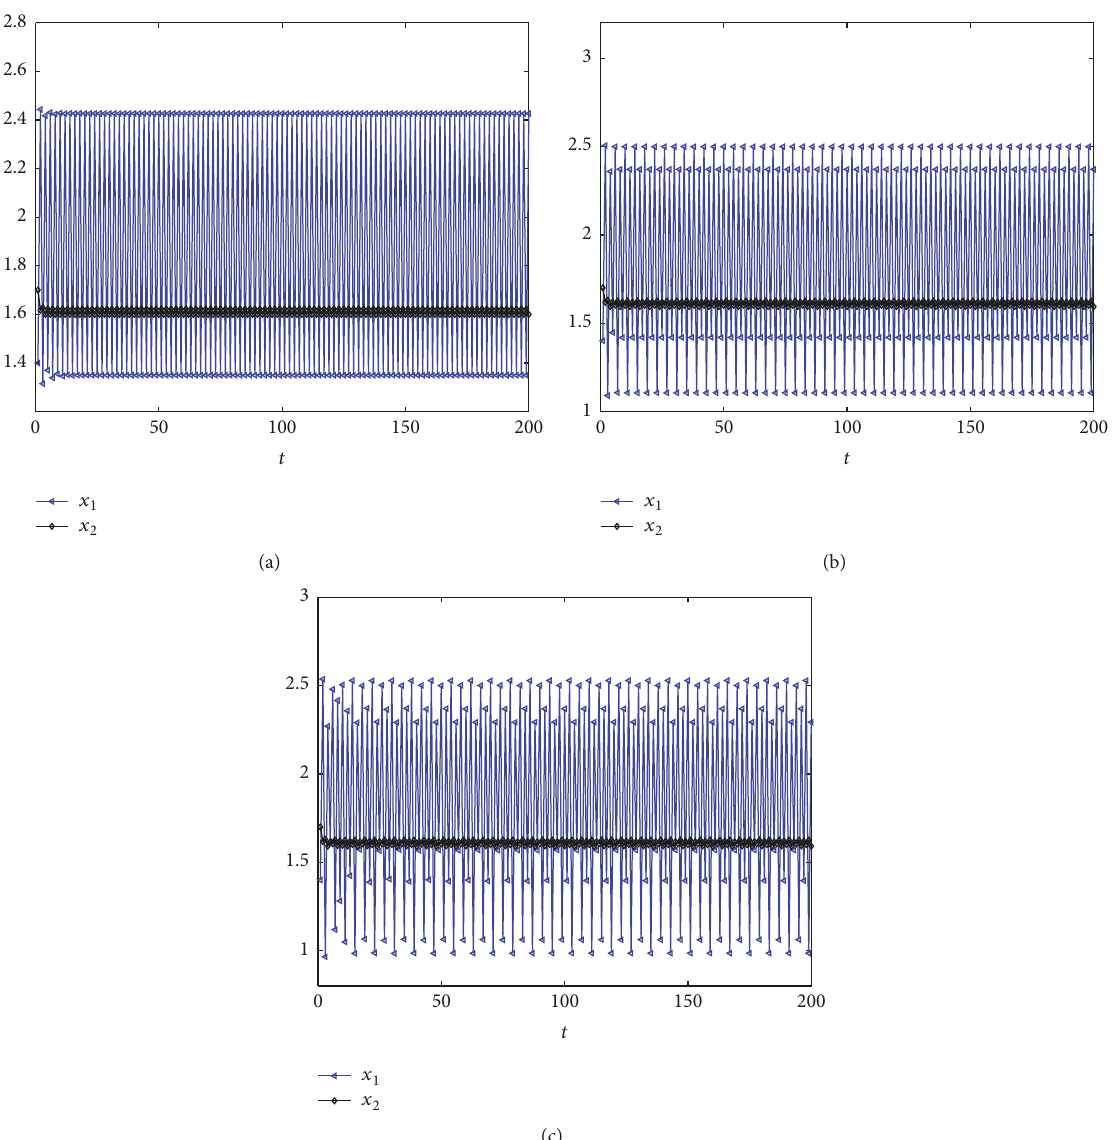
Figure 4: Phase diagram of system (9) for (a) (𝛼 1 = 1.18, 𝛼 2 = 0.36) ; (b) (𝛼 1 = 1.25, 𝛼 2 = 0.36) ; (c) (𝛼 1 = 1.285, 𝛼 2 = 0.36)